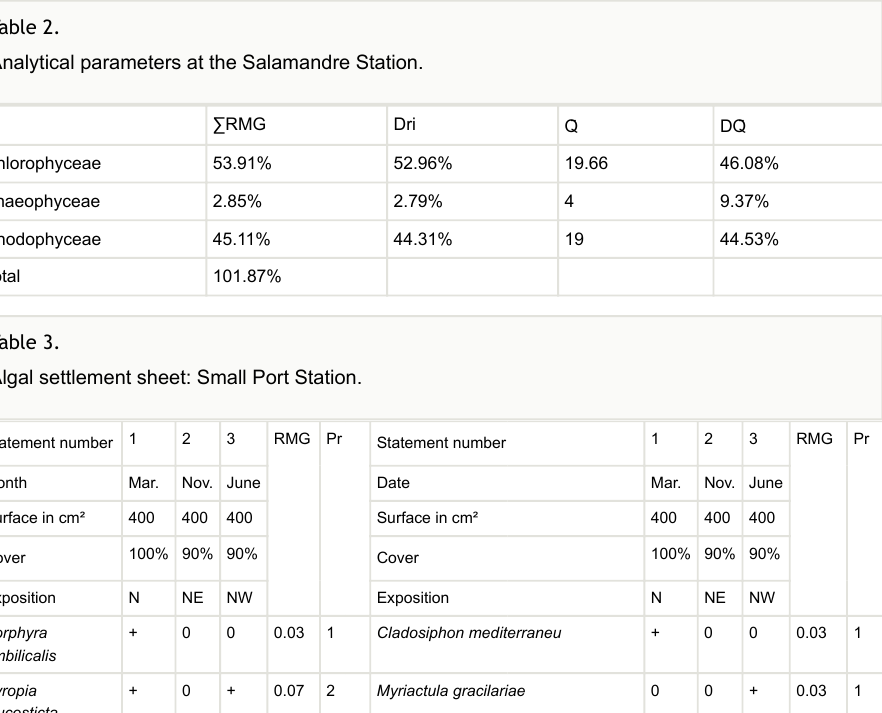
Antithamnion amphigeneum A.